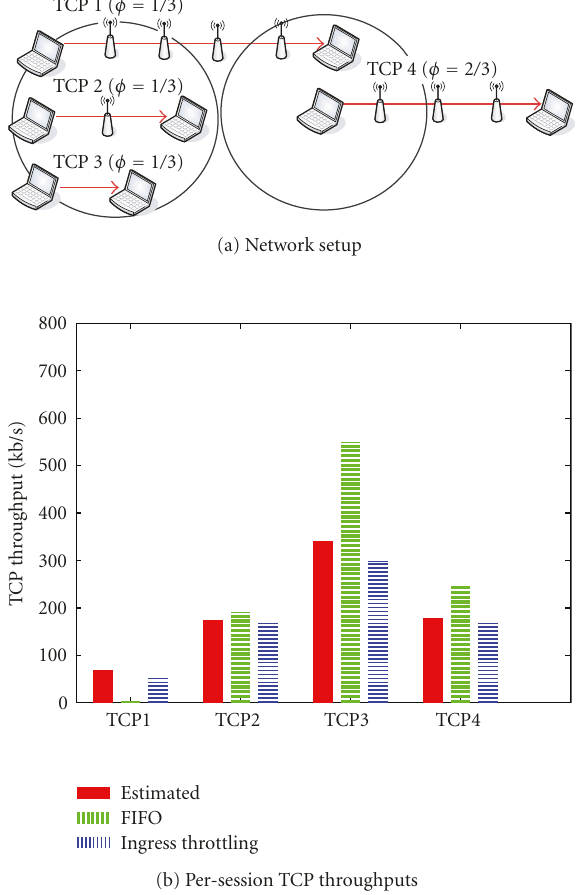
Figure 7: Network setting for the multiple bottleneck experiment and performance results.